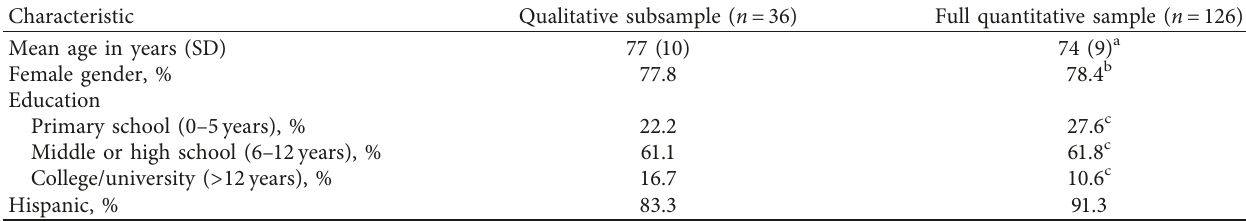
Table 1: Demographics comparison of qualitative subsample of older adult AMOB/VLL participants to full quantitative sample.